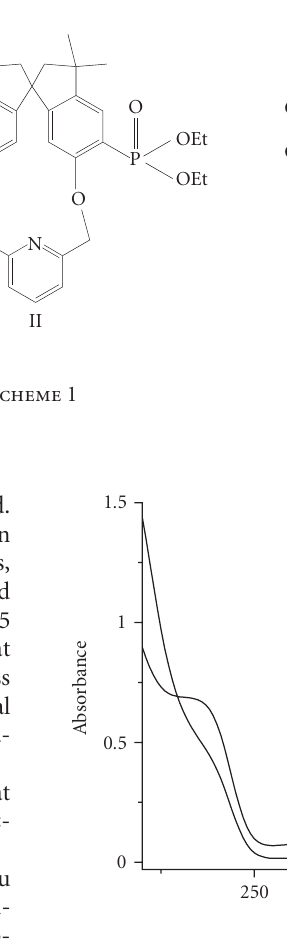
Figure 1: Absorption spectra of (1) 2 10 (cid:0) 5 M of (II) in the presence of 8 and (2) 2 (cid:0)